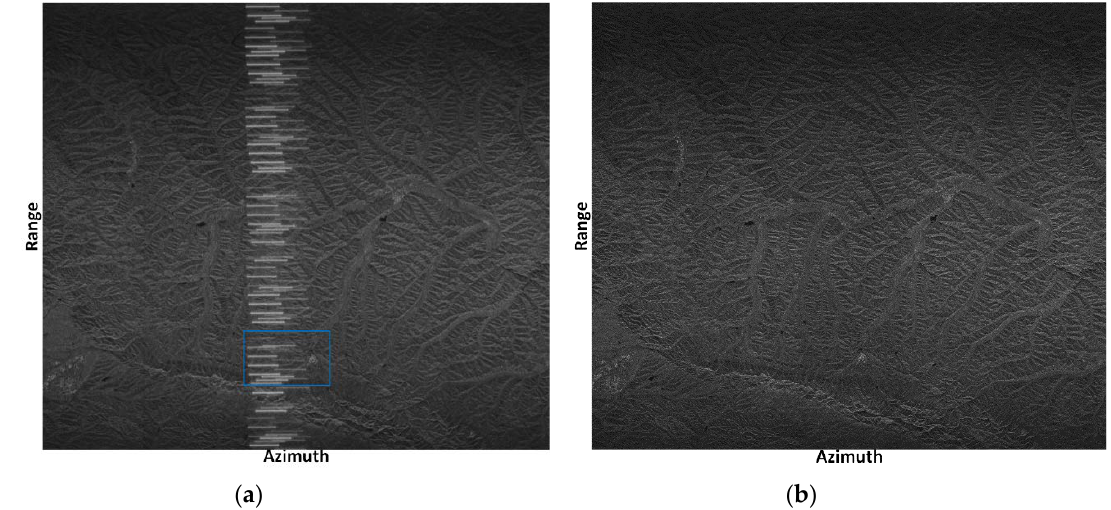
Figure 16. The SAR imaging results (a) without interference mitigation and (b) after IMN.